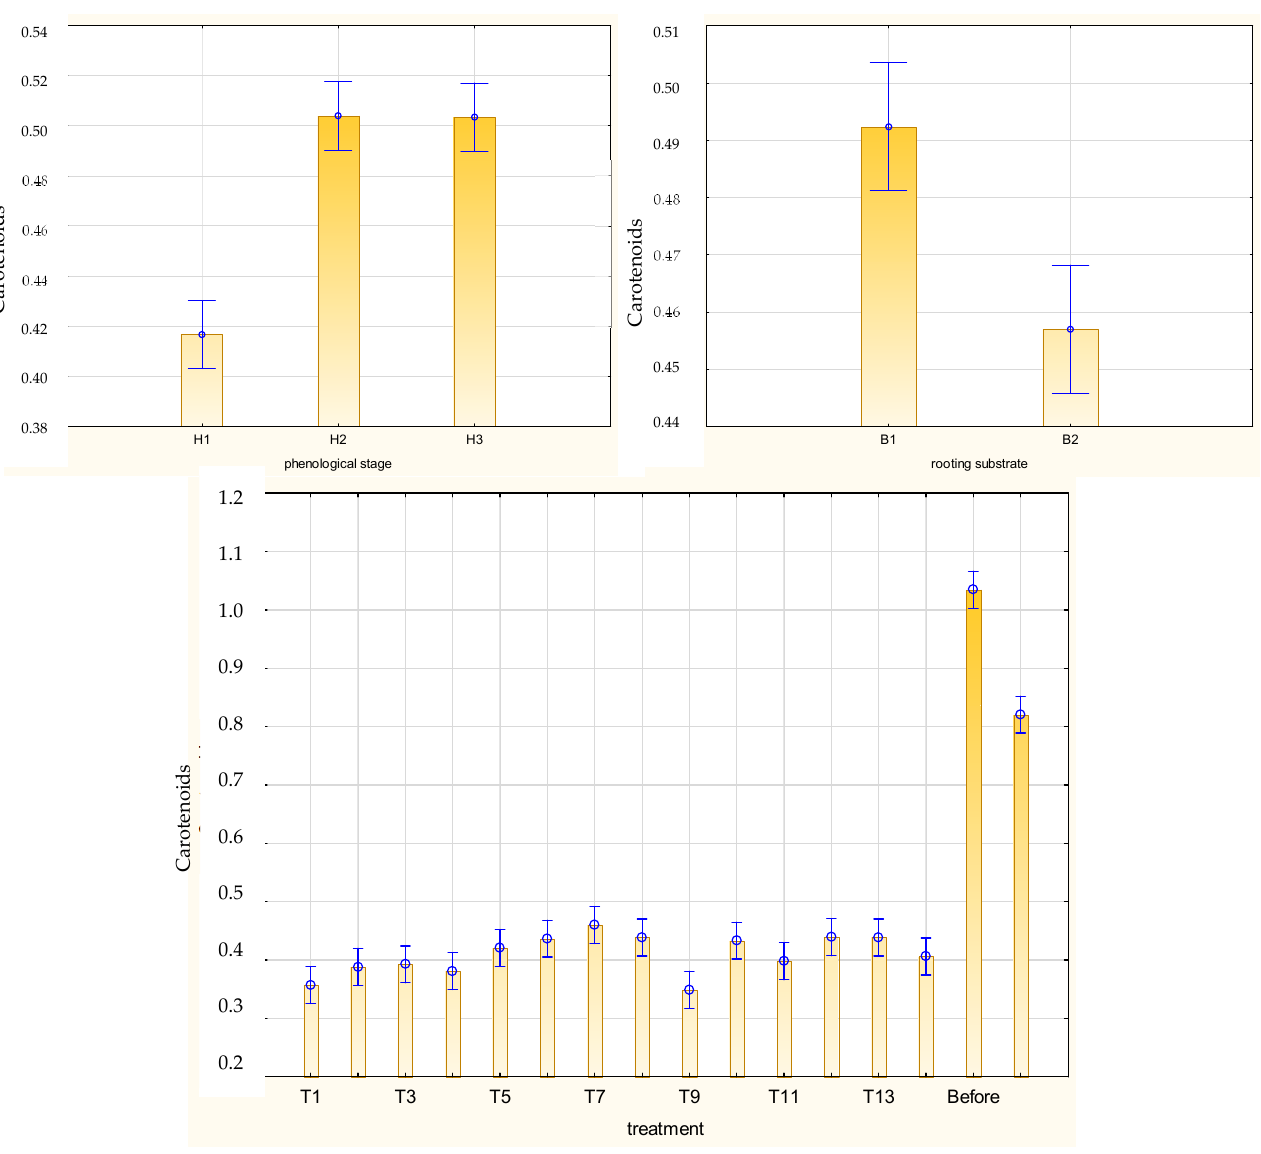
Figure 10. Content of carotenoids (mg·g − 1 FW) in leaves of Rosa ‘Hurdal’ cuttings prepared from three phenological stages (H1–H3) of shoots and rooted in two rooting substrates after treatment by rooting enhancers. B1—peat–perlite; B2—peat–sand; H1—flower buds closed (BBCH 54,504; flower buds still closed); H2—flowers opened (69,605; full flowering, at least 50% of flowers open); H3— immediately after petal shedding (69,629; end of flowering of second order stem: all petals fallen); and treated: T1—the control cuttings; T2—0.4% IBA (Ukorzeniacz A aqua ); T3—0.2% NAA (Ukorzeniacz B aqua ); T4, T5, T6, T7, T8, T9—Algae Extract: watering with 0.4% or 0.6% Bio Rhizotonic (10 mL) 1, 2, or 3 times (after planting and 10 and 20 days later); T10, T11, T12—Organic Preparation— watering with 0.1%, 0.2%, or 0.4% Root Juice™ (10 mL) after planting; T13, T14—Plant Extract— watering with 0.012% or 0.02% Bio Roots (10 mL) after planting. The degree of rooting on a 5-point scale: 1—only a callus, without formed roots; 2—at least one short root; 3—a few longer roots; 4— roots visibly developed, differentiated by the length; 5—strong roots starting to form a root ball, well developed. Vertical bars denote 95% confidence intervals for the mean of counts (one-way ANOVA).